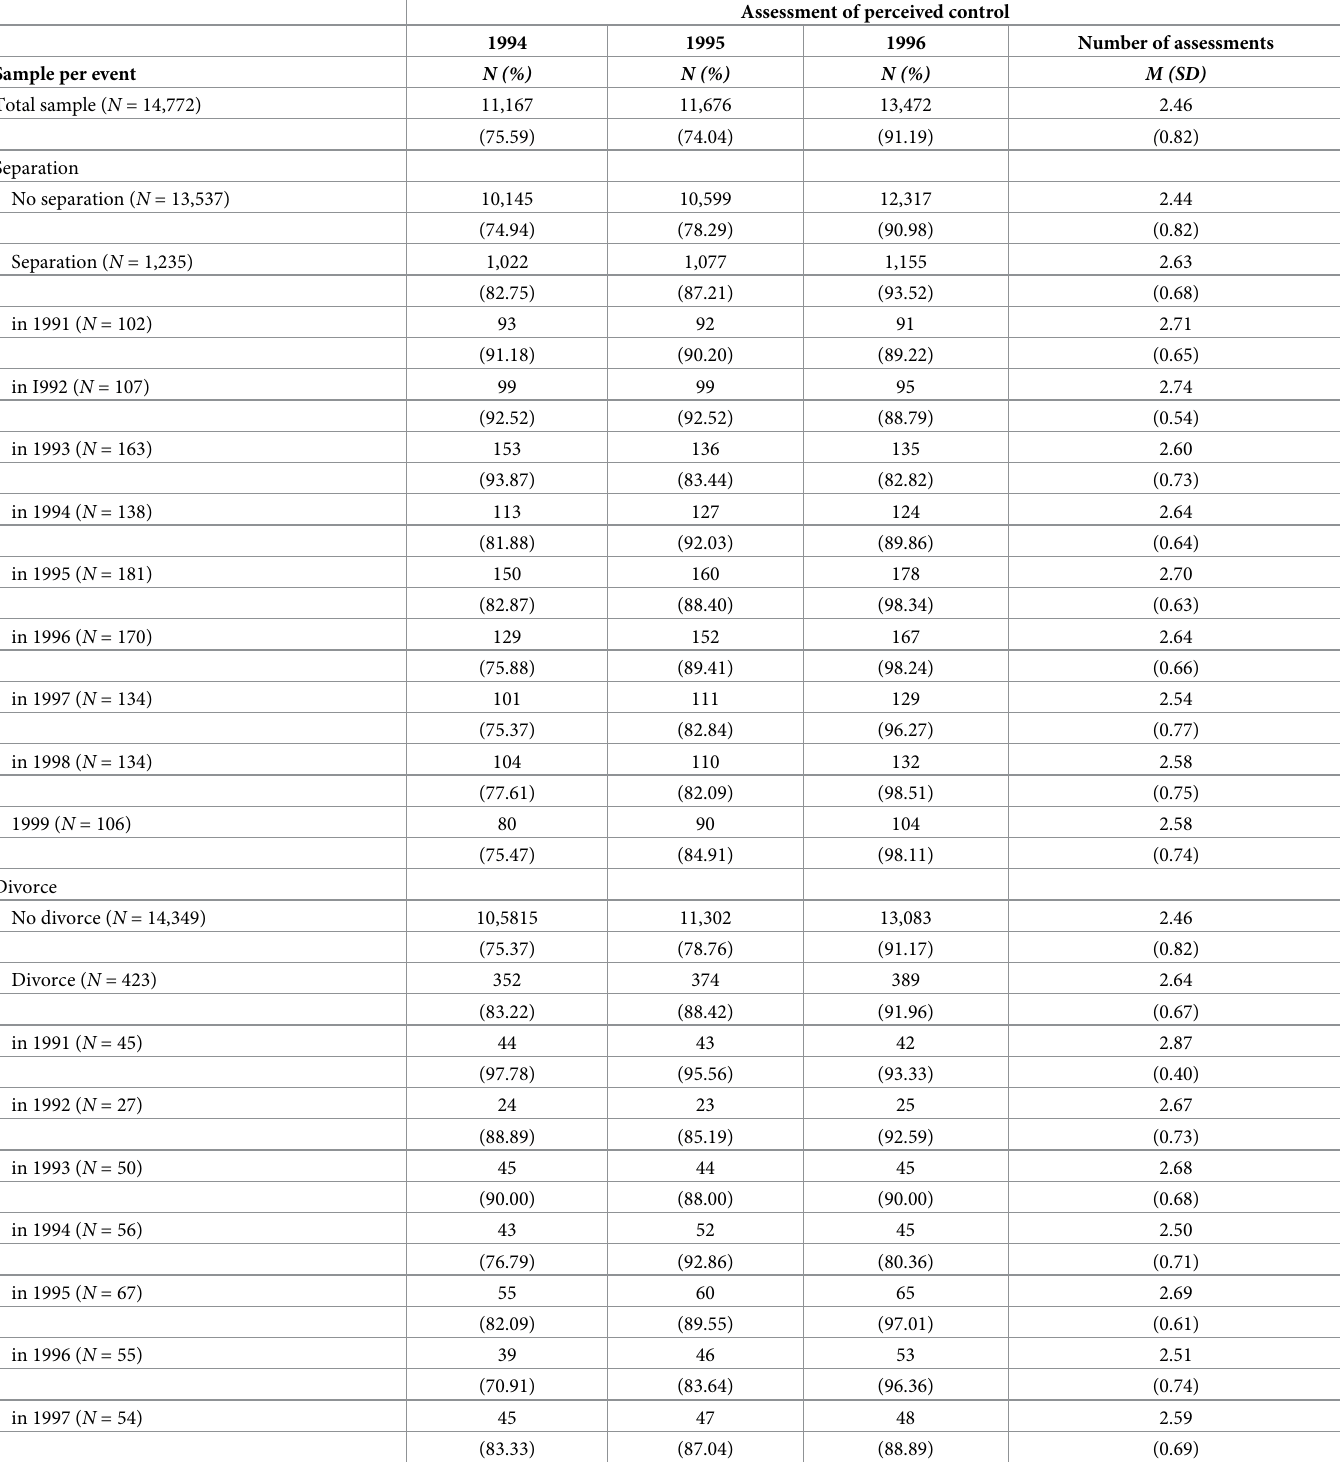
Table 2. Frequencies and percentages of individuals who did and did not experience the respective loss between 1991 and 1999 and provided information on per- ceived control in 1994, 1995, and/or 1996 (including information on the overall number of assessments; N =